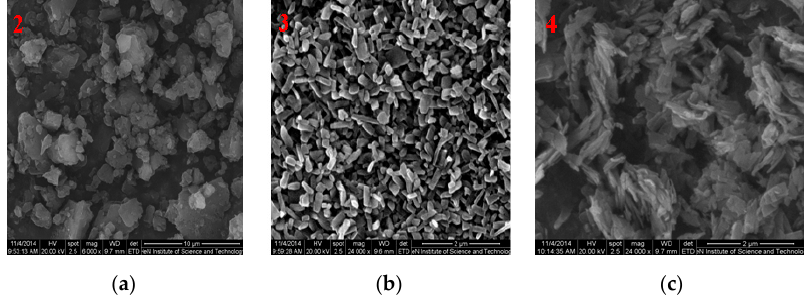
Figure 1. SEM images of compounds. ( a ) Compound 2 ; ( b ) Compound 3 ; ( c ) Compound 4 .